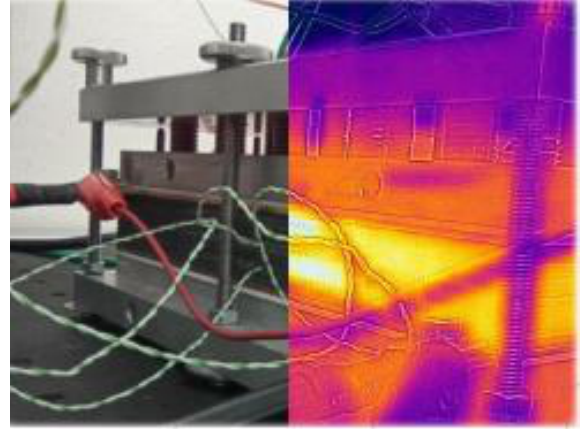
Fig. 6. Visualization of the temperature distribution at the fuel cell inlet - original adapter .